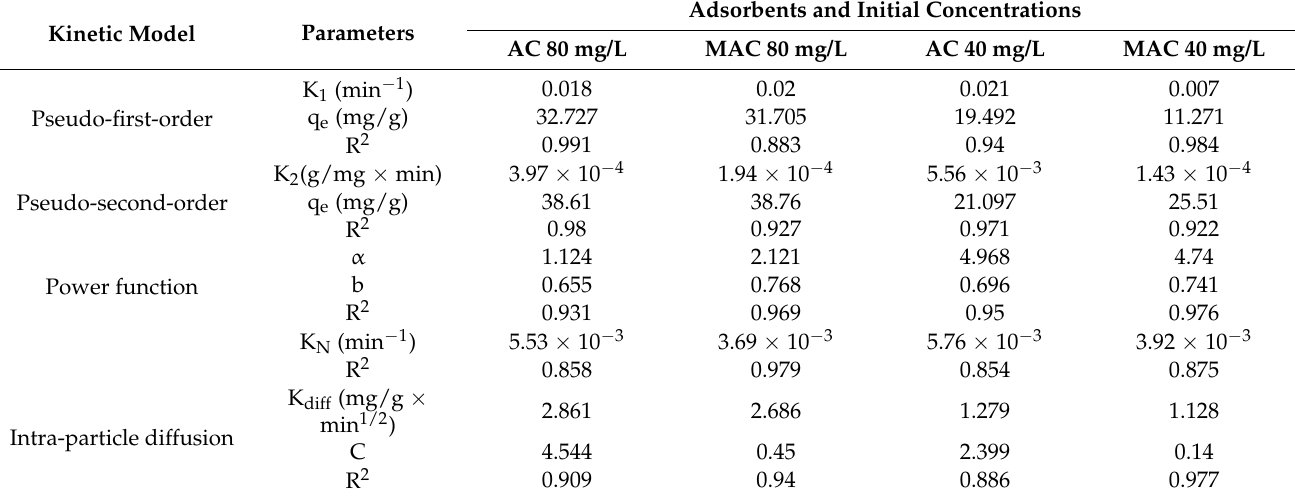
Table 3. Kinetic characteristics for AZM adsorption of MAC and